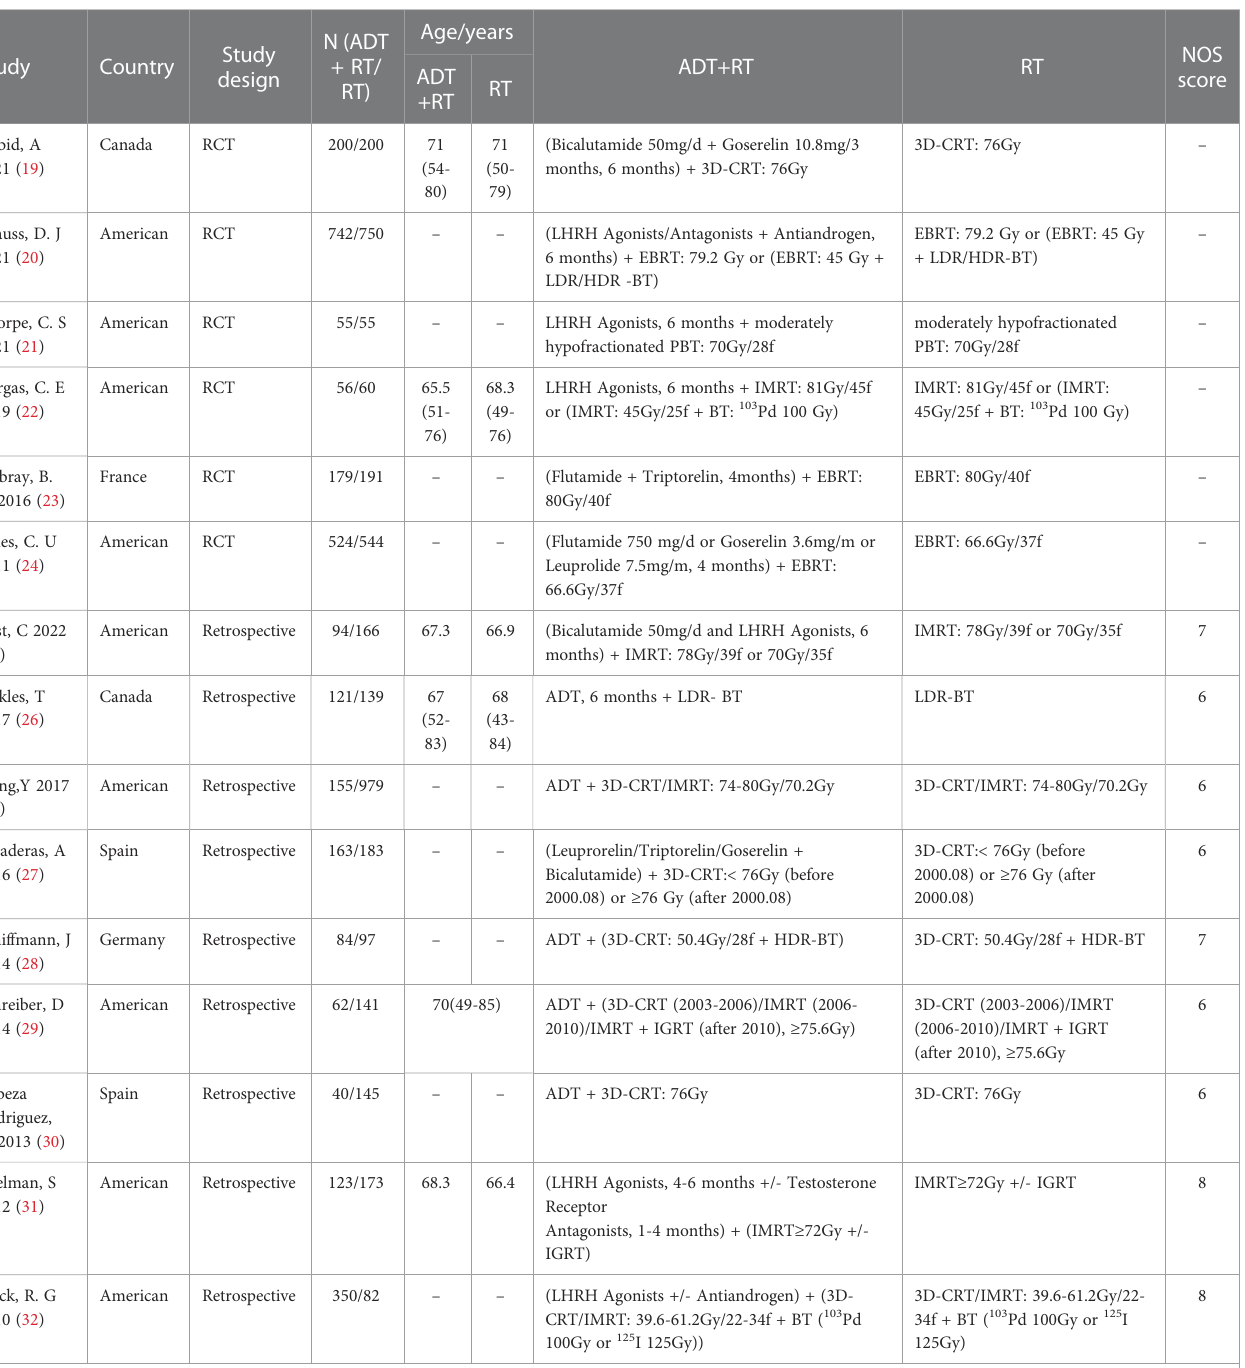
TABLE 1 Characteristics of studies